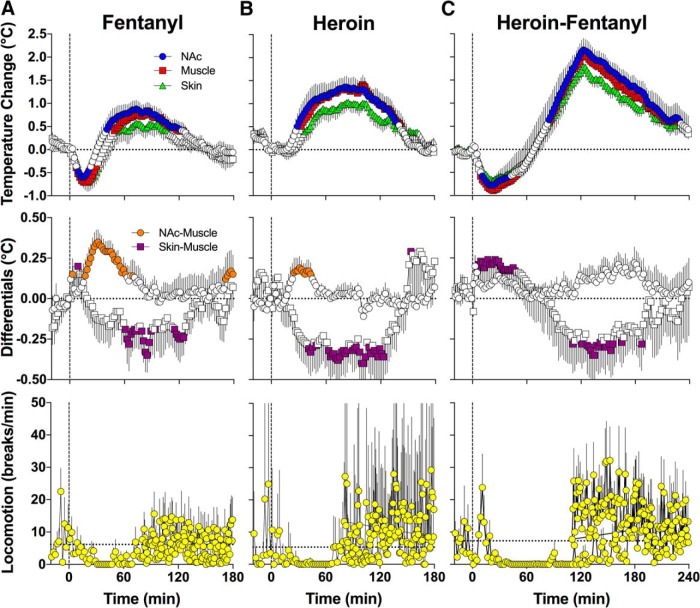
Changes in temperature in the NAc, temporal muscle, and skin (top row), NAc-muscle and skin-muscle temperature differentials (middle row), and locomotor activity (bottom row) induced by intravenous injections of fentanyl (40 µg/kg; A), heroin (400 µg/kg; B), and their mixture (40 µg/kg fentanyl + 360 µg/kg heroin; C) in awake, freely moving rats. Values significantly different from baseline (p < 0.05; horizontal hatched lines) are shown as filled symbols. Moment of drug injection (time = 0 min) is shown as vertical hatched line.